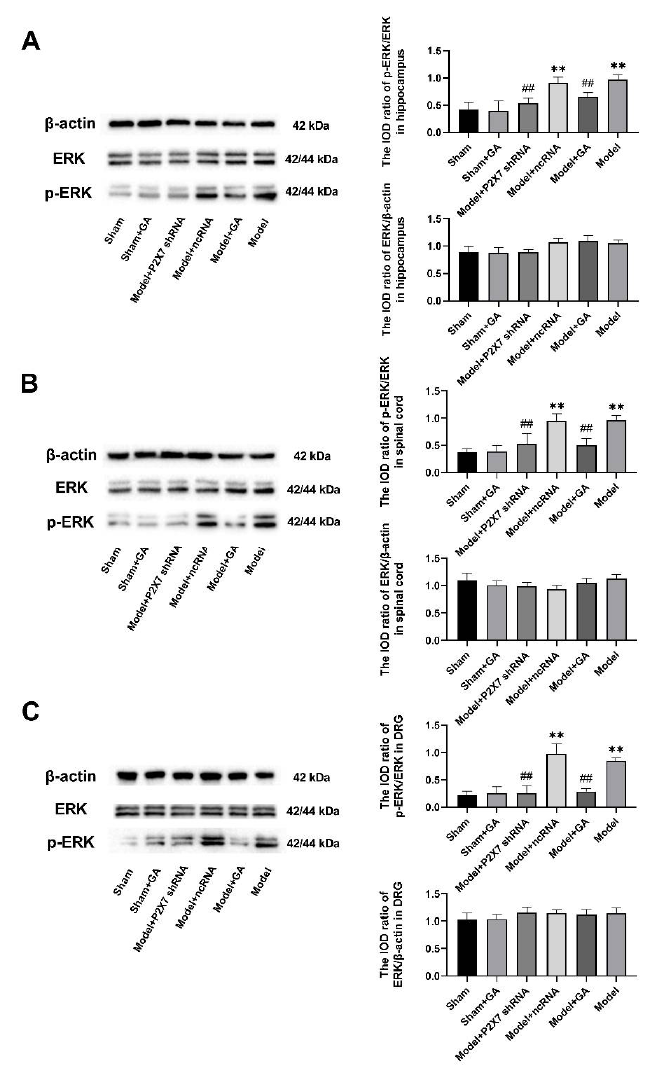
Figure 8. The effects of GA on ERK and phosphorylation of ERK1/2 in the hippocampus ( A ) (F(5,30) = 25.222, p < 0.001), spinal cord ( B ) (F(5,30) = 30.171, p < 0.001), and DRG ( C ) (F(5,30) = 55.567, p < 0.001) were determined by Western blotting. β -Actin was used as the housekeeper gene in all tissue types. Values are means ± SEM. N = 6 per group. ** p < 0.01 vs. sham group; ## p < 0.01 vs. model